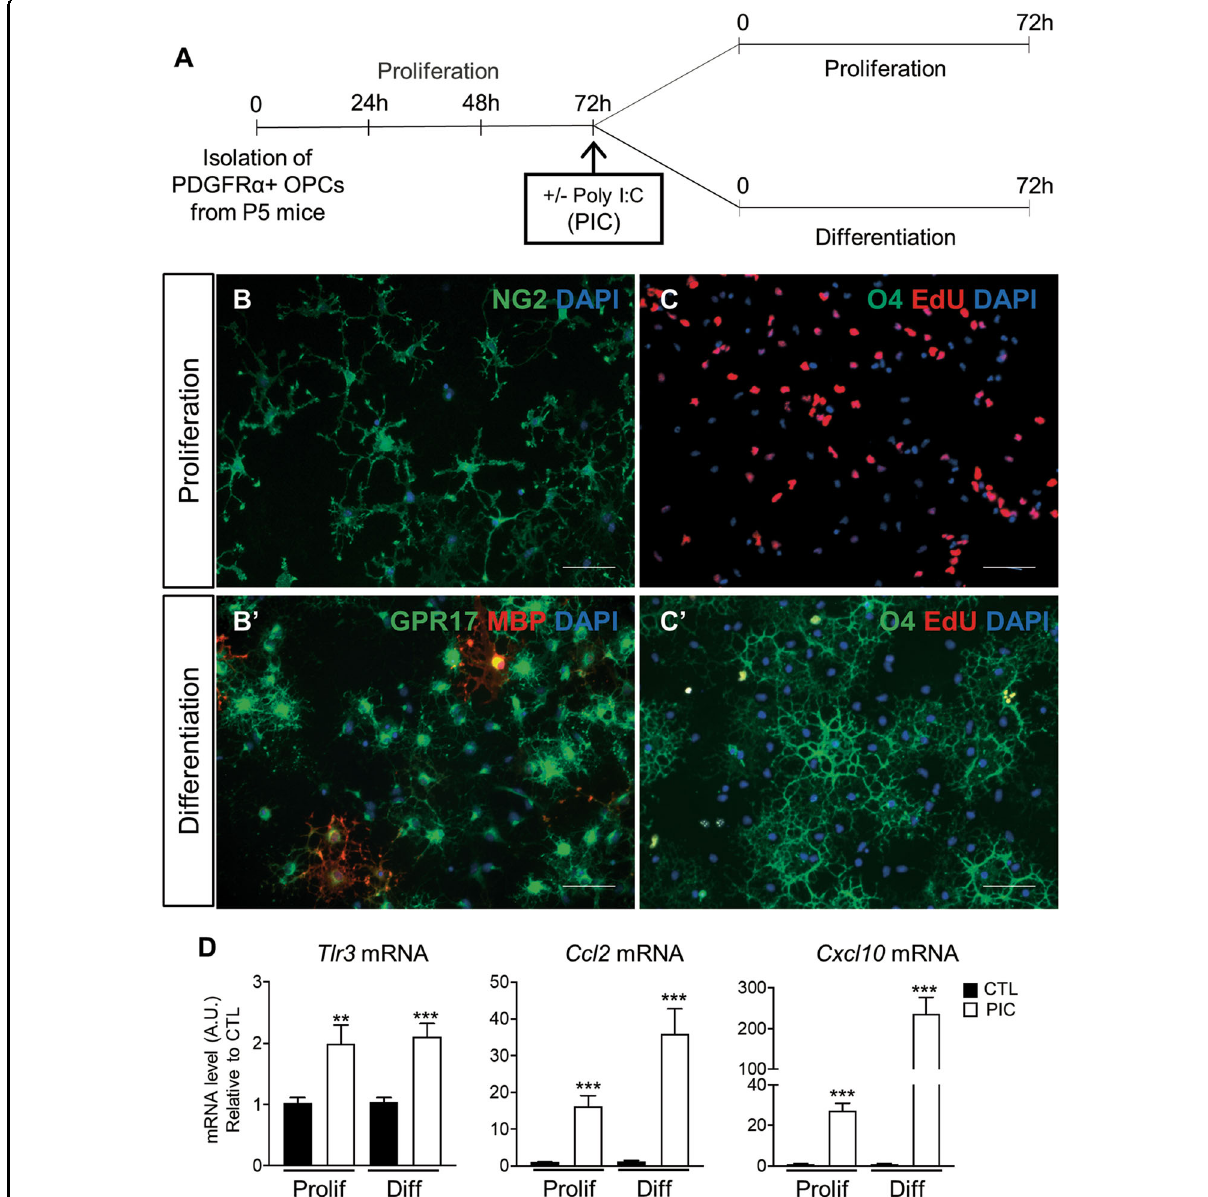
Fig. 4 In vitro treatment with TLR3 agonist Poly(I:C) induces TLR3 activation both in proliferating and differentiating OLs. A Experimental scheme. B – C ’ Immuno fl uorescence staining for NG2, O4, GPR17, MBP, and EdU of OLs cultured in proliferating ( B – C ) or differentiating ( B ’– C ’